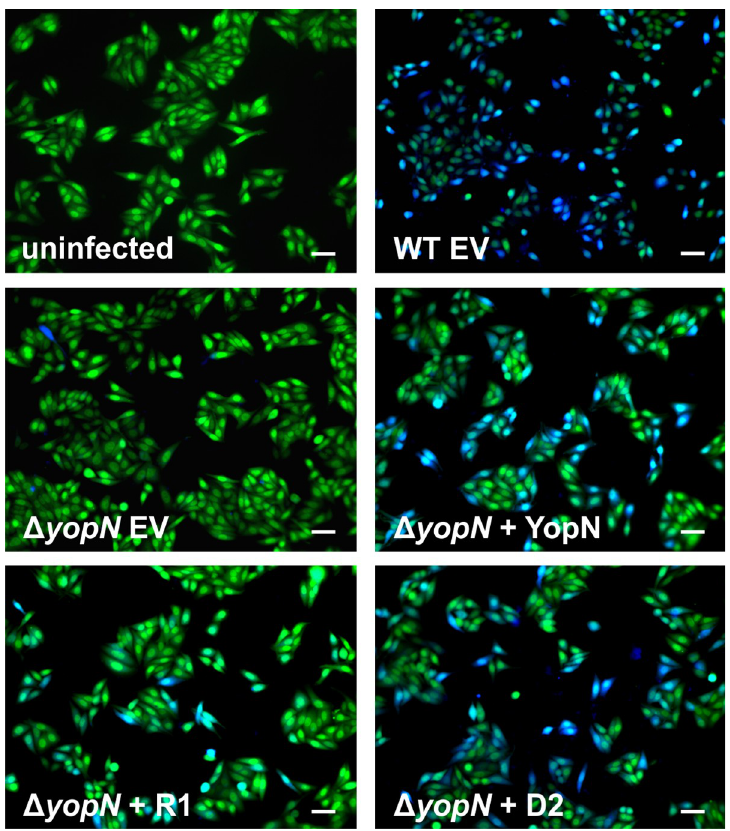
Fig 8. Visualization of YopE translocation into HEp-2 cells. YopE translocation assay of Y . pseudotuberculosis YPIII wild type (WT) and Δ yopN with the empty vector pGM930 (EV) and Δ yopN with vectors containing arabinose- inducible complementation constructs of yopN with the wild type RNAT, the stable variant R1 or the open variant D2. All strains carry plasmid pMK- bla coding for a yopE - bla TEM fusion. HEp-2 cells were infected with bacterial strains at an MOI of 50, labeled with CCF4-AM and analyzed by fluorescence microscopy. Blue fluorescence signals of HEp-2 cells indicate efficient YopE-TEM translocation. scale bars: 50 μ m.